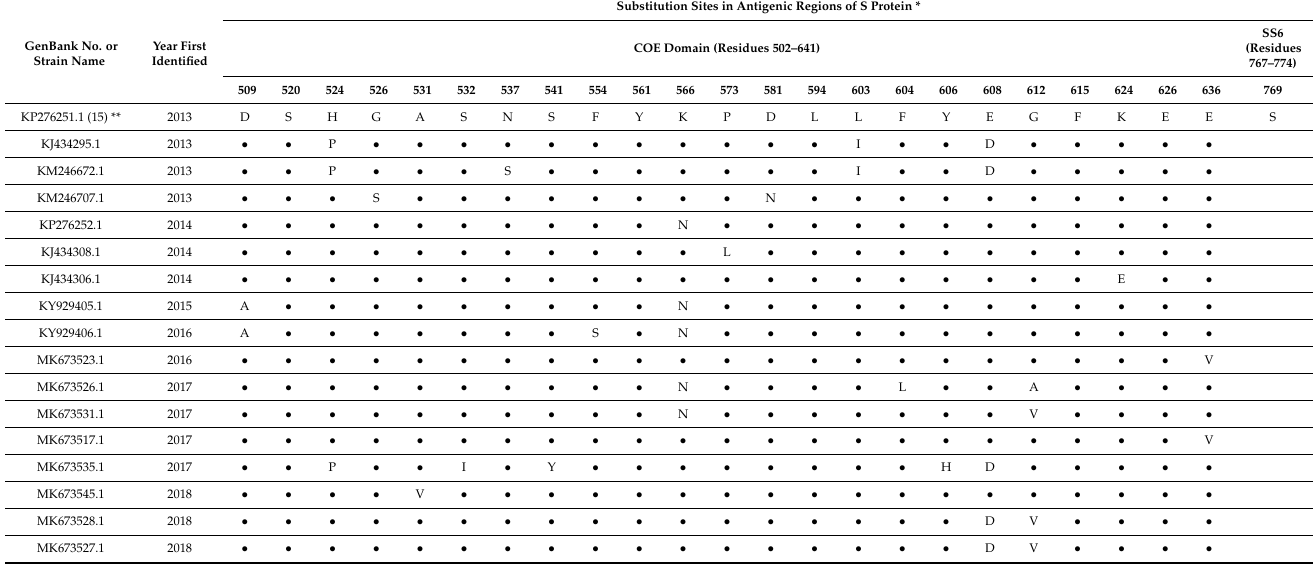
Table 4. Alignment summary of amino acid sequences of the antigenic regions in S protein among the strains identified in this study and those of Taiwanese PEDV strains published in